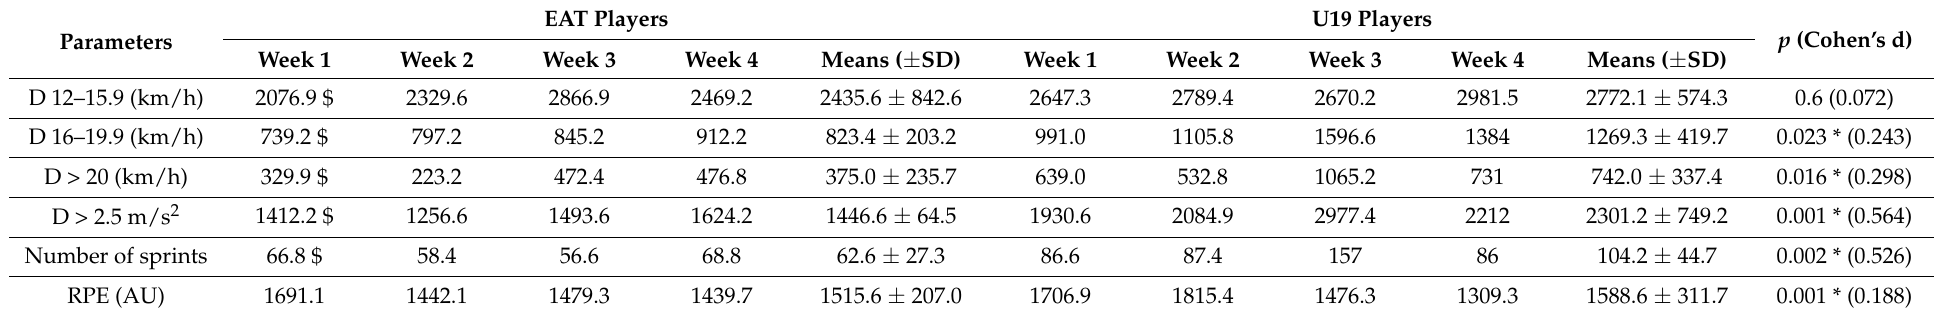
Table 3. Internal and external training load of U-19 and professional teams over four